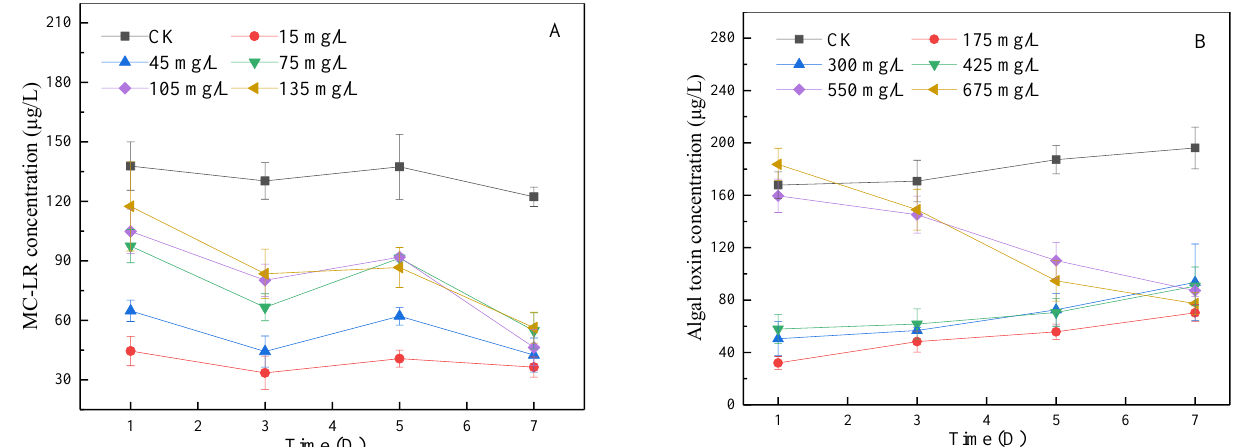
Figure 7. The effect of SA-CS on the concentration of MC-LR in algal liquid at lag phase and log phase: ( A ) the effect of SA-CS on MC-LR at lag phase; ( B ) the effect of SA-CS on MC-LR at log phase. Under similar conditions, Microcystis with an initial chlorophyll concentration of 1 mg/L was destroyed by copper ions for 7 days, and the concentration of MCs in water increased by 1.65 times [45]. After adding SA-CS, the concentration of MC-LR decreased by more than 50% in both the log phase and retarded phase, indicating that SA-CS had a good degradation effect on MC-LR.